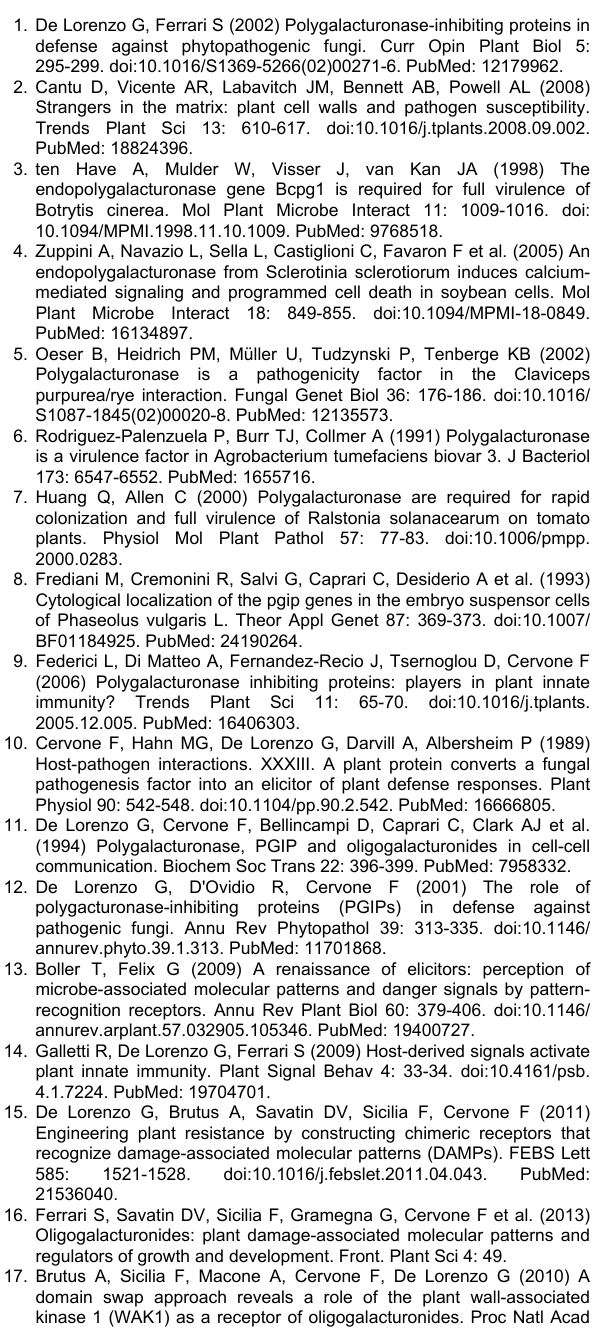
Figure S1. Western blot analysis using a polyclonal antibody against the FpPG, on the mutated and wild-type forms of FpPG and FvPG producing an equal enzymatic activity on the agar diffusion